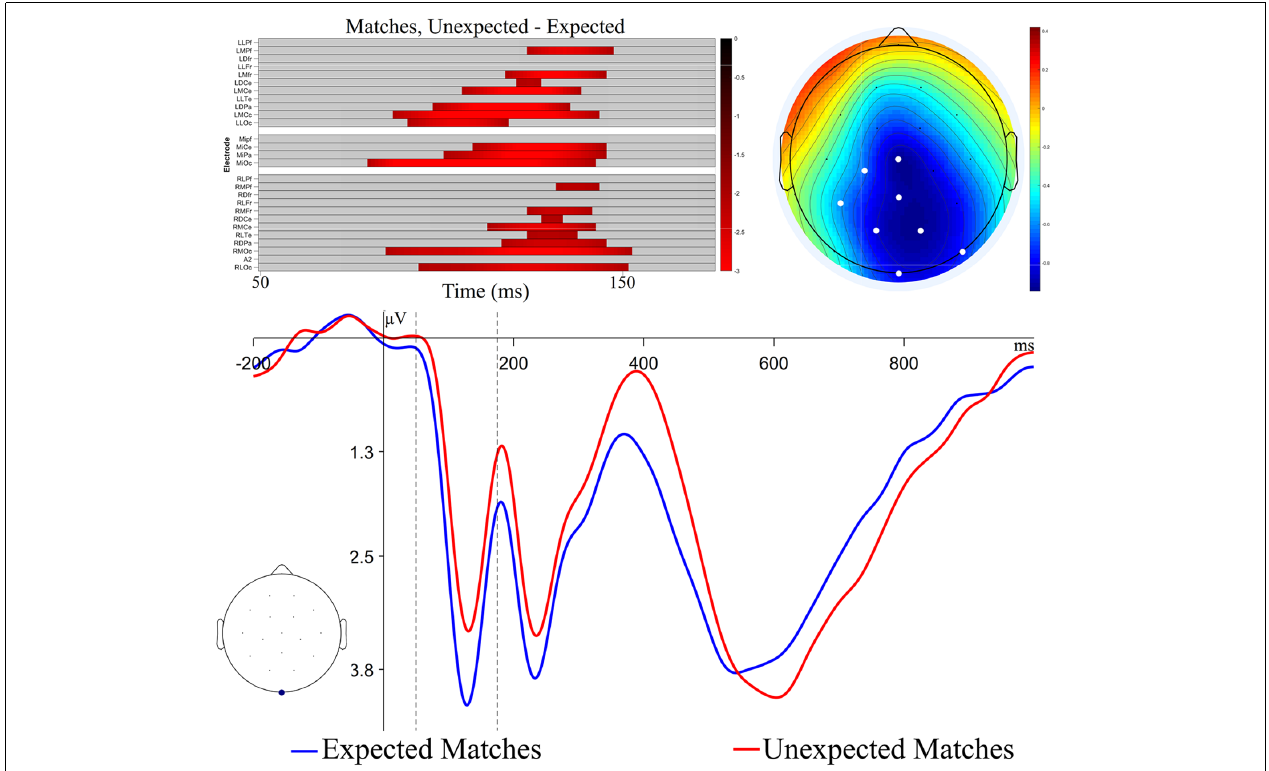
FIGURE 4 | Permutation test results and ERP plots for analyses of N1 recognition memory effect. The raster plot show channels and time-points which make up the significant cluster found in the permutation tests. Colors represent the t -value at the time-point. The ERP topography plot shows the mean amplitude in the time window of the significant cluster, with significant channels highlighted in white. The ERP plot shows the Expected and Unexpected Match ERPs at the channel with the largest t -value within the cluster (MiOc). The black dashed lines indicate the time range of the permutation